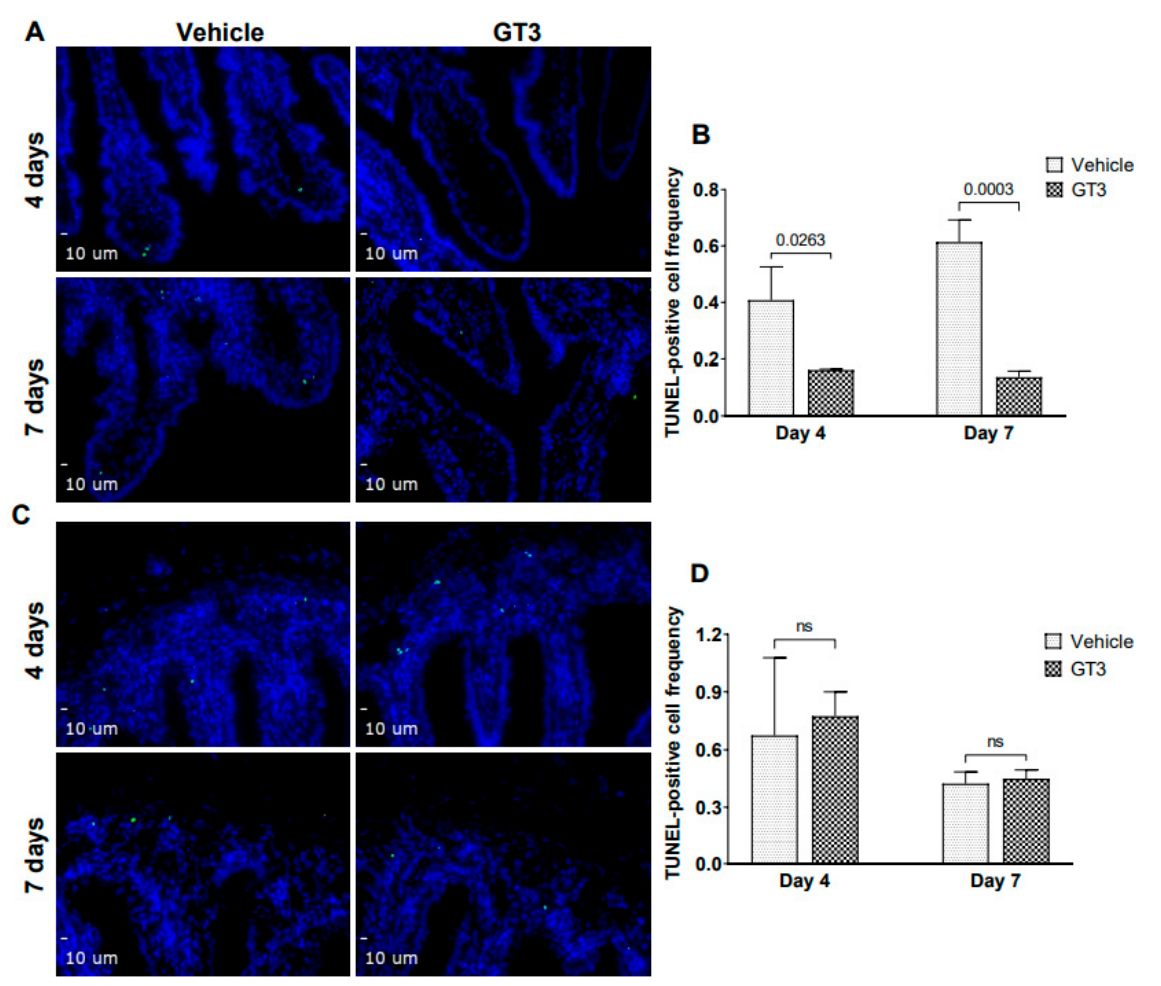
Figure 3. Effects of GT3 on TBI-induced intestinal damage. ( A ) Representative photomicrograph of TUNEL-positive cells (green) in the intestinal villi. ( B ) Frequency of TUNEL-positive cells in villi at day 4 and 7 post-TBI in vehicle and GT3-treated groups. ( C ) Representative photomicrograph of TUNEL-positive cells (green) in the crypt. ( D ) Frequency of TUNEL-positive cells in the crypts at day 4 and 7 post-TBI in vehicle and GT3-treated groups. The data are presented as average ± SEM; N = 3 (day 4) and N = 5 (day 7). ns = not significant.